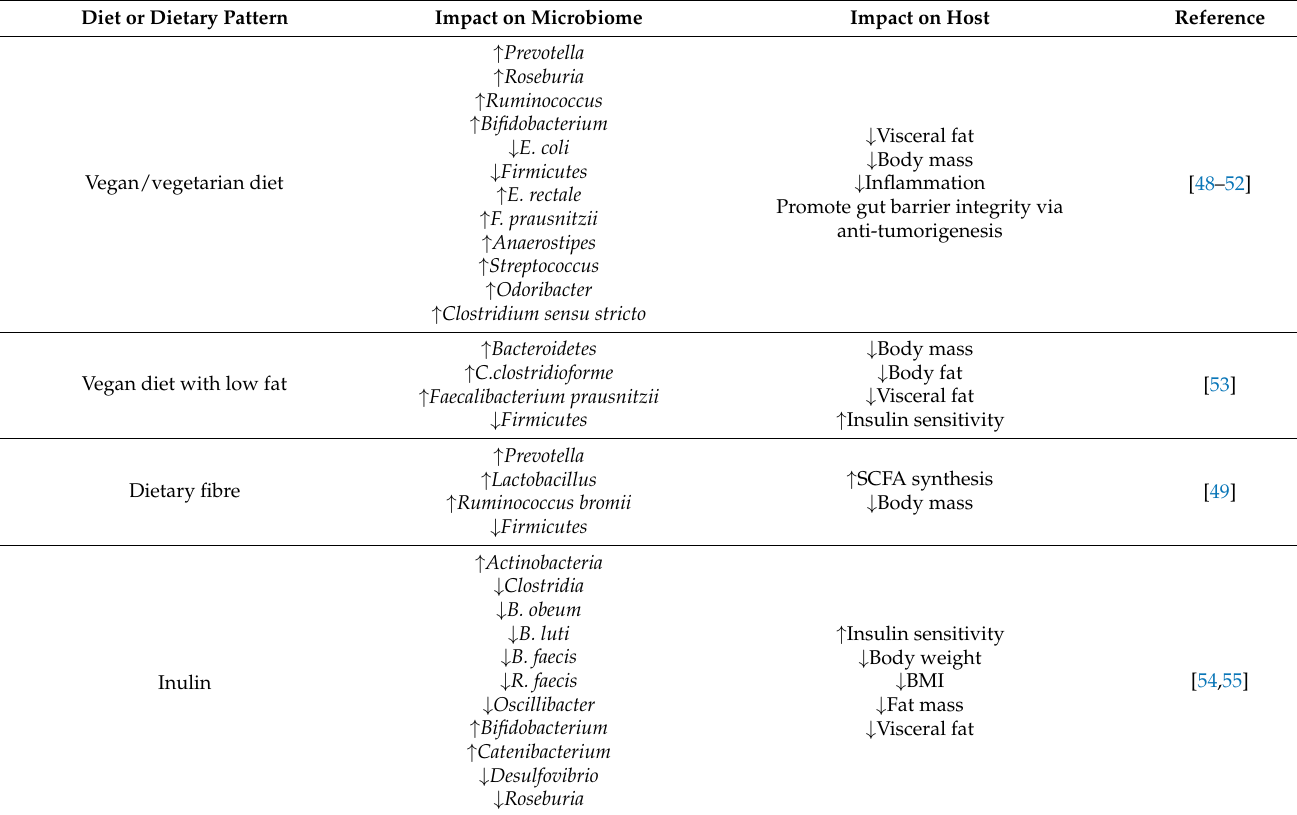
Table 2. Effect of diet and dietary components on the gut microbiome and host ( ↑ : increased; ↓ :